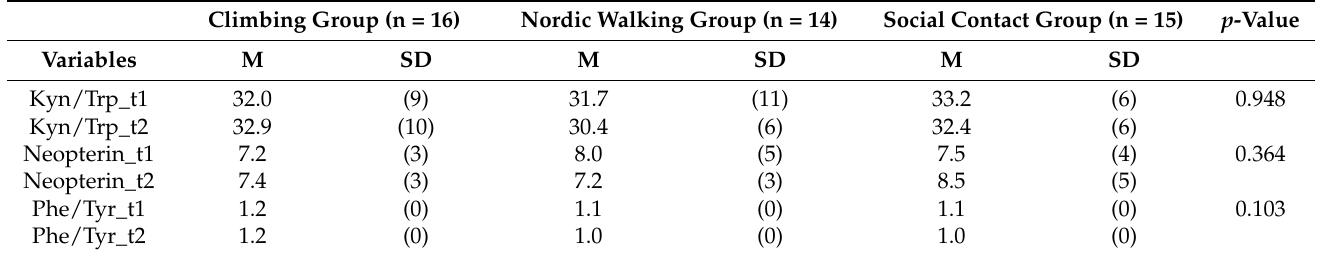
Table 3. Group comparison of the changes in biological parameters including descriptive values by